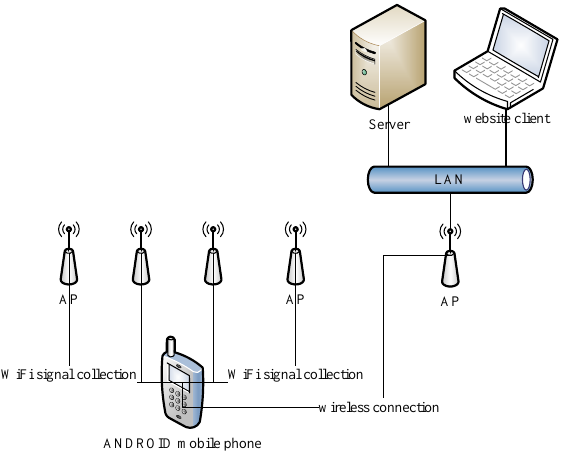
Figure 2. The fourth floor of software building layout.